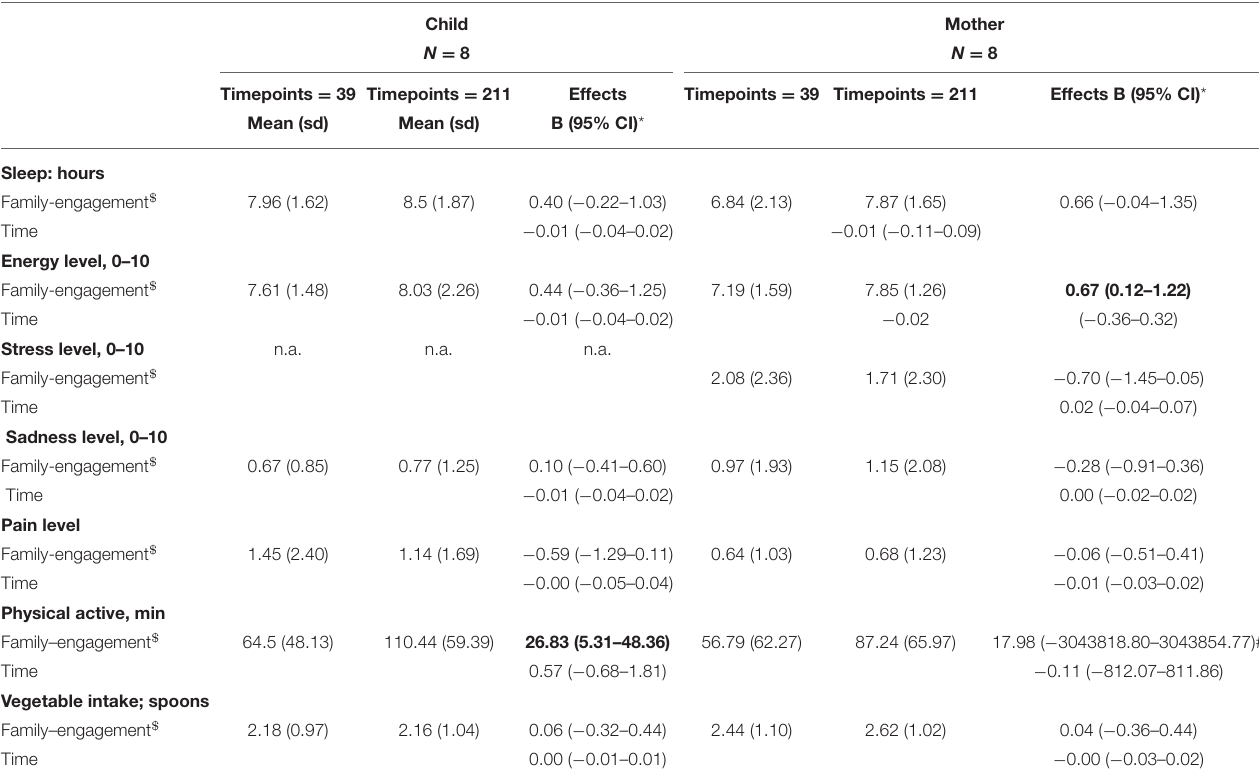
TABLE 2 | Multi-level time-series analyses of the combined effects on well-being and health behavior of children and